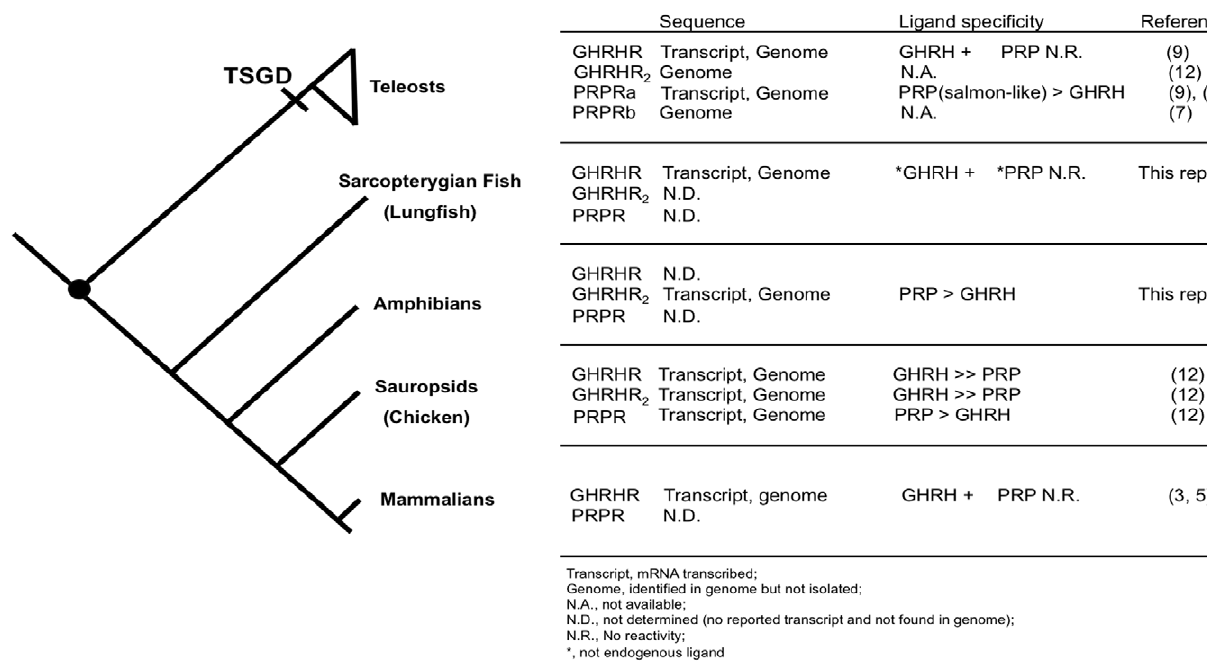
Figure 4. Gene linkage comparisons of GHRHRs in the Osteichthyes lineage. Genes in vicinity of GHRHR were mapped, and syntenic genes were linked by straight lines. Size of the chromosomal region analyzed was given underneath based on the current edition of Ensembl databases. Syntenic genes encoding other secretin GPCR receptors were drawn in grey boxes, and the conserved flanking genes of GHRHR were drawn in closed boxes. (A) Gene environment of GHRHR in the Sarcopterygii lineage represented by human, mouse, lizard, chicken, frog and coelacanth was compared. Despite the syntenic genomic locations of GHRHR and neighbouring genes from human to avians, GHRHR was not located in frog. (B) Gene environment of GHRHR in the Actinopterygii lineage represented by fugu, tetraodon, stickleback, medaka, and zebrafish. Apart from the less conserved genomic region of zebrafish GHRHR, genes in proximity of other teleost GHRHRs were highly syntenic. However, they displayed an entirely different gene environment when compared to the sarcopterygian GHRHRs. (C) Genomic location analysis of xGHRHR characterized in present work and GHRHR 2 in zebrafish and chicken. Gene synteny could neither be identified inter-species nor between the two GHRHR genes in the same species. The figures were not drawn to scale.